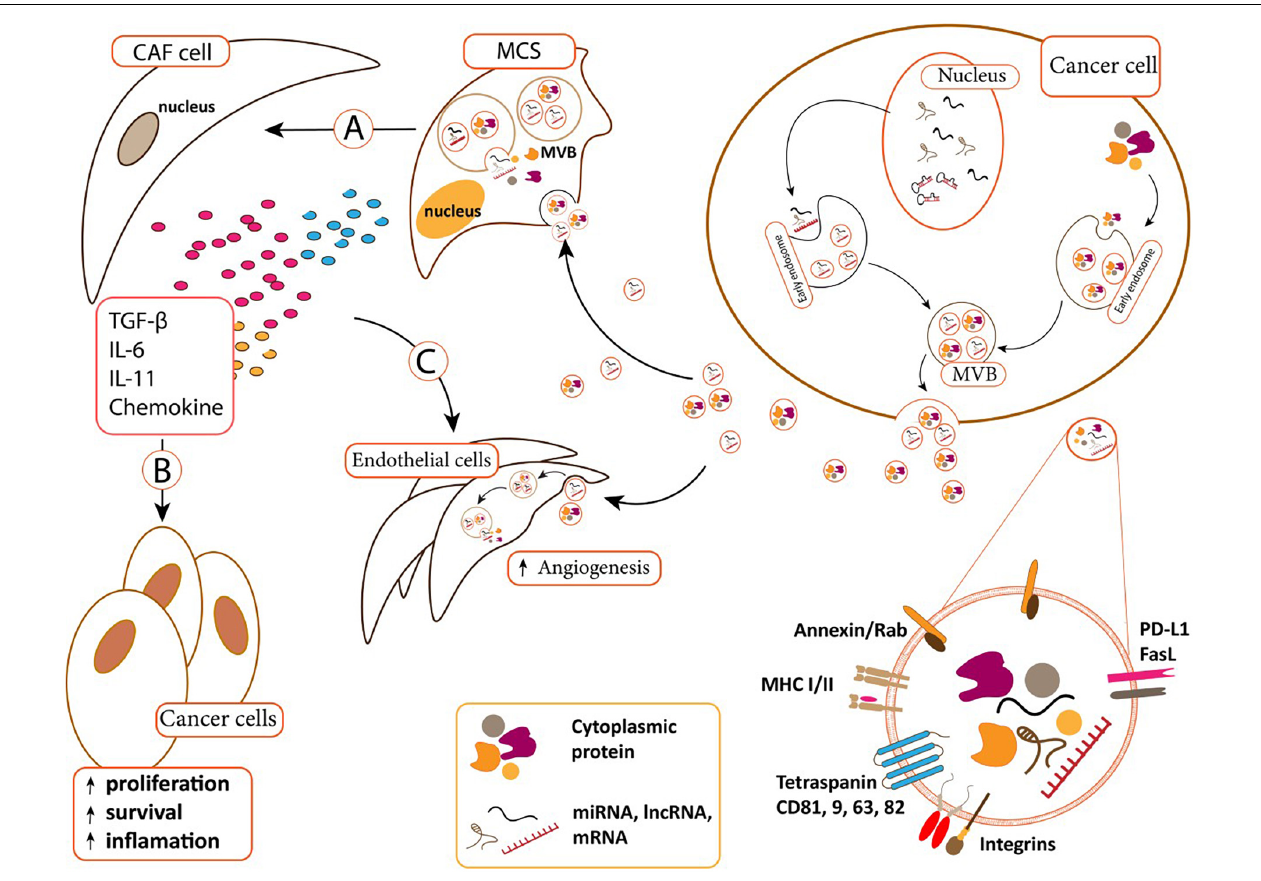
FIGURE 3 | (A) Cancer-derived exosomes can transfer to MSCs and change MSCs. MSCs differentiated to cancer-associated fibroblast (CAF) in B.M microenvironment. (B) CAFs supports cancer cells via secreted content such as TGF- β , IL-11, IL-6, and chemokine. CAF secreted contents affect cancer cells and increase cancer cell proliferation, survival. (C) Cancer derived exosomes can also uptake by endothelial cells and induce angiogenesis. CAFs secreted content can also induce angiogenesis in endothelial cells (Padua and Massagué, 2009; Mineo et al., 2012; Pickup et al., 2013; Costanza et al.,